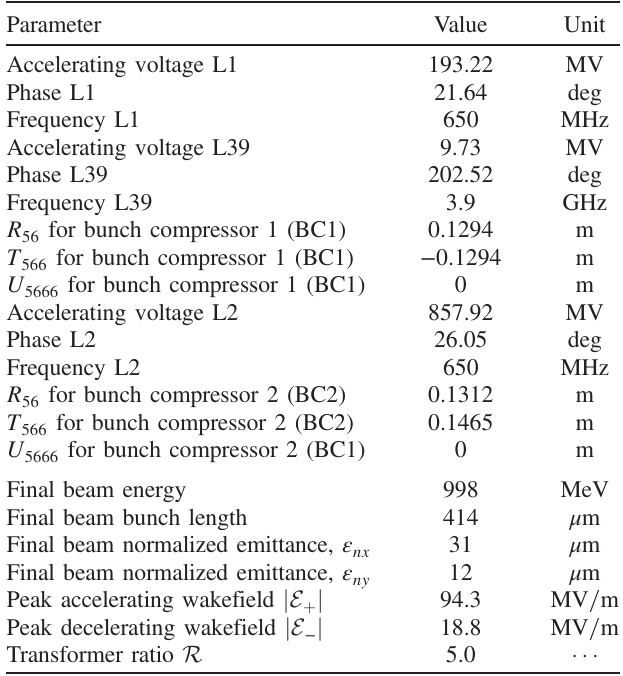
=E ¼ 1 . 5 × 10 − 3 . In E . TABLE IV. Main accelerator parameters and beam parameters E at the end of